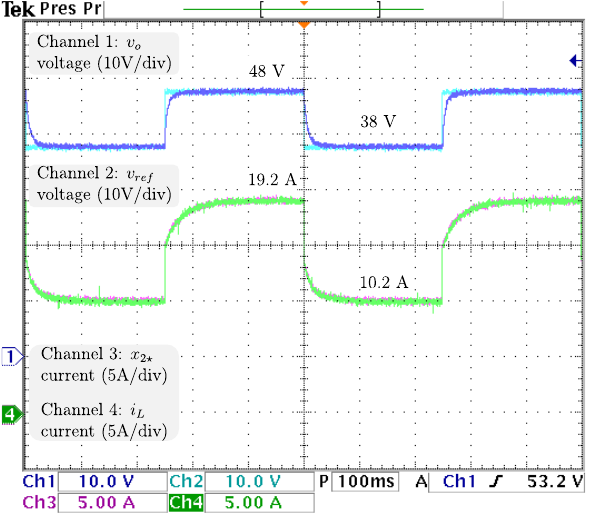
Figure 9. Real-time results for sudden output voltage changes. From top to bottom: v o , the output